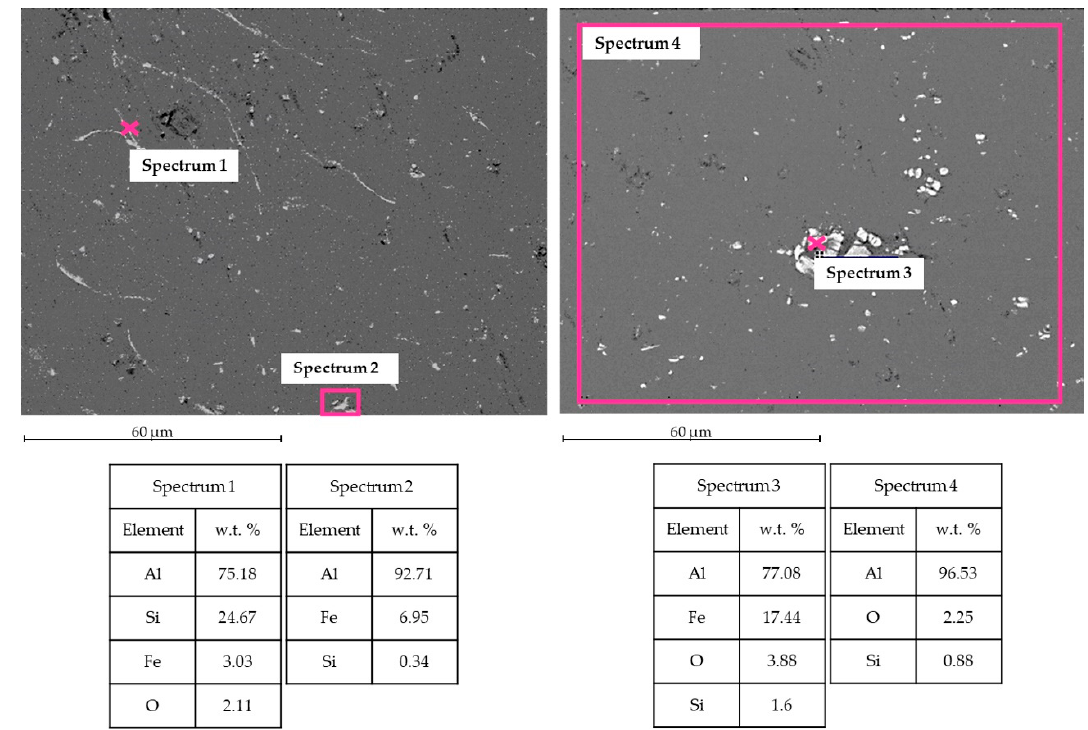
Figure 8. TIG welding analysis. Left side: SEM image and EDS in WZ. Right side: SEM image and EDS in HAZ.